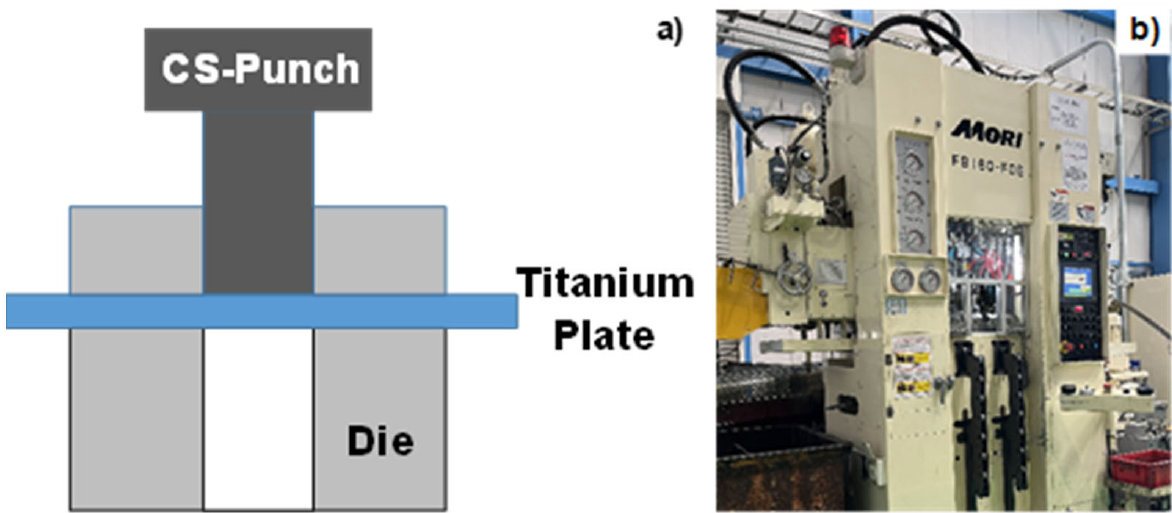
Figure 2. Fine ‐ blanking system: ( a ) schematic view of the fine ‐ blanking process and ( b ) overview of Figure 2. Fine-blanking system: ( a ) schematic view of the fine-blanking process and ( b ) overview of the fine ‐ blanking system. the fine-blanking